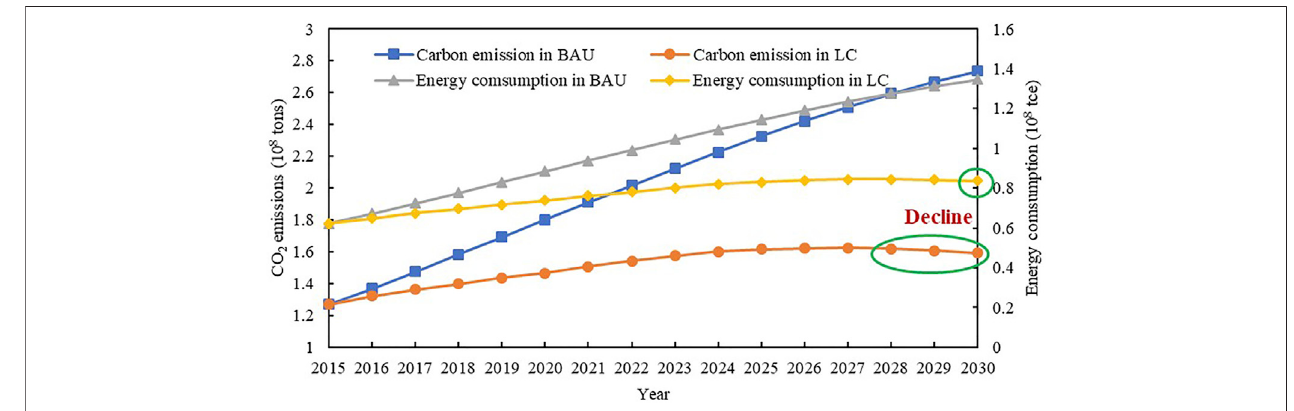
FIGURE 2 | The trend of energy demand and CO 2 emissions for transportation in Guangdong Province from 2015 to 2030.